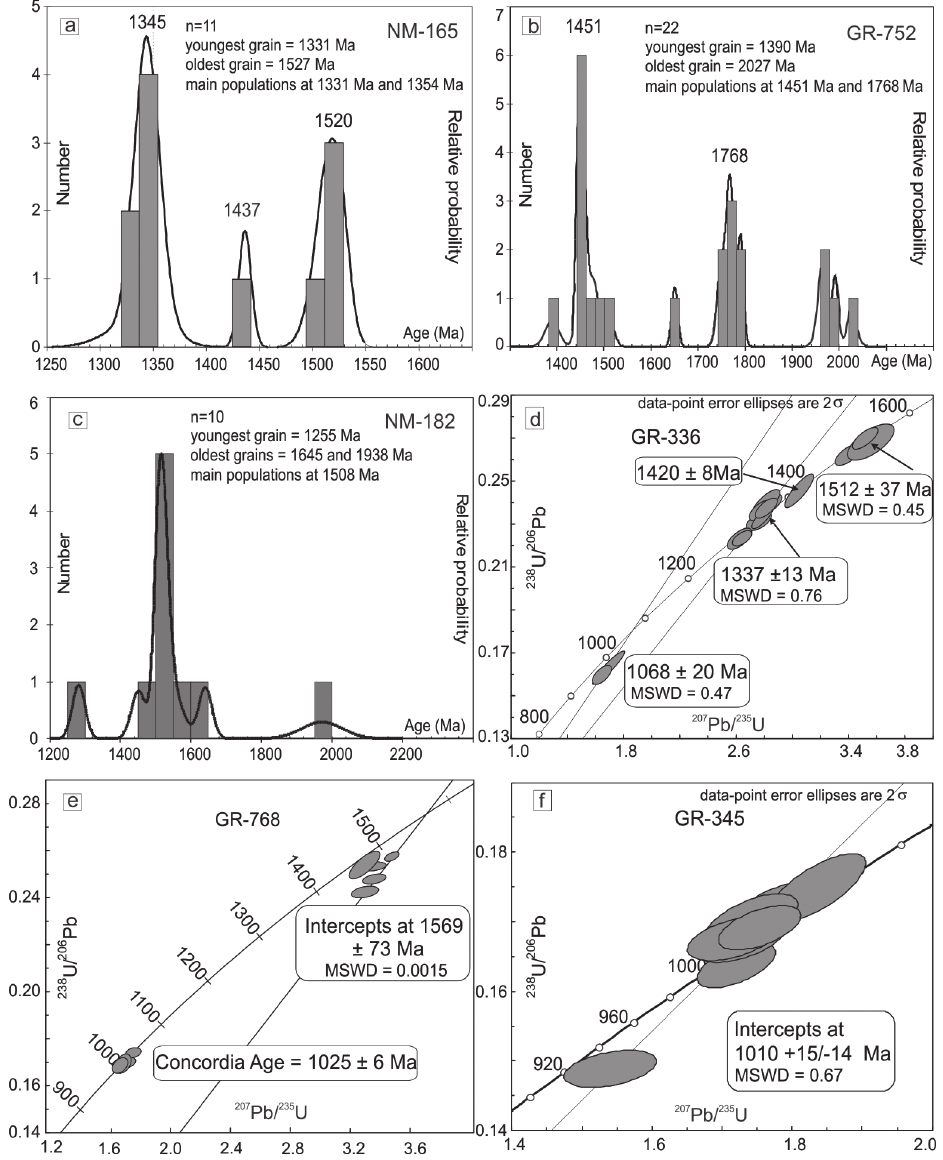
Figure 5 - U-Pb concordia plots and relative probability plots of zircon ages from samples of the Aguapeí belt and intrusives